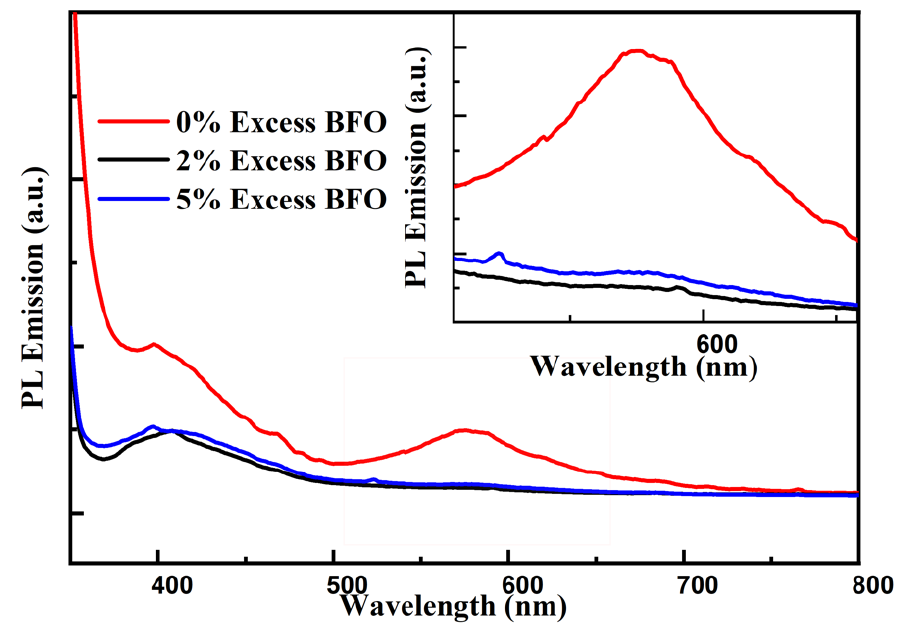
Figure 4. PL spectrum of BiFeO 3 (0%, 2% and 5% Excess Bi) nanoparticles.